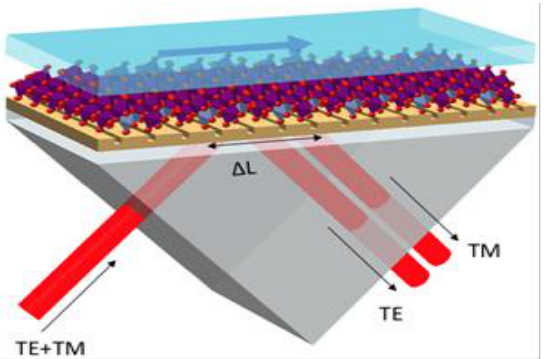
Figure 1. Schematic representing the Kretschmann SPR sensor based on a gold metasurface: prism, glass substrate, gold, and Vanadium dioxide as the sensing layer.